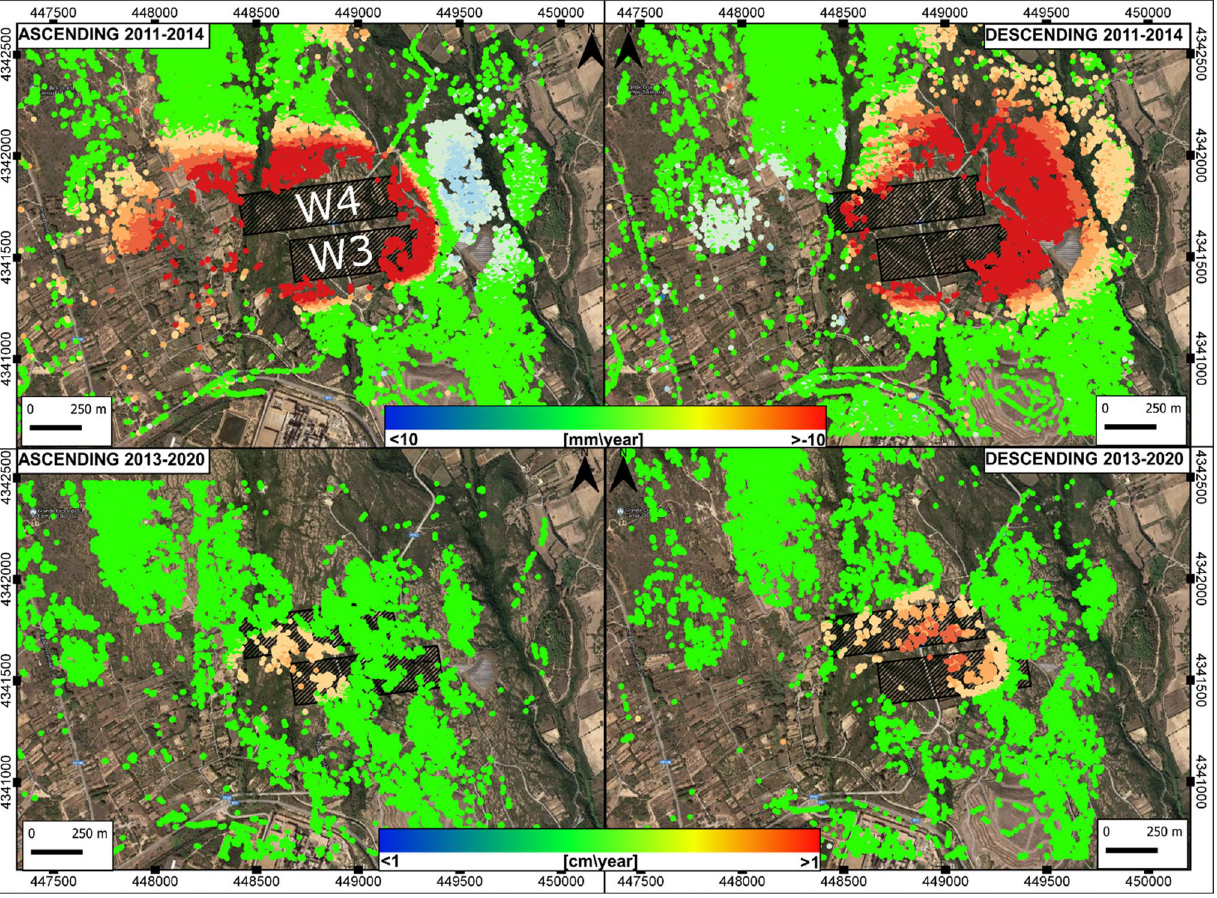
Fig. 6 Mean displacement rate maps in ascending and descending